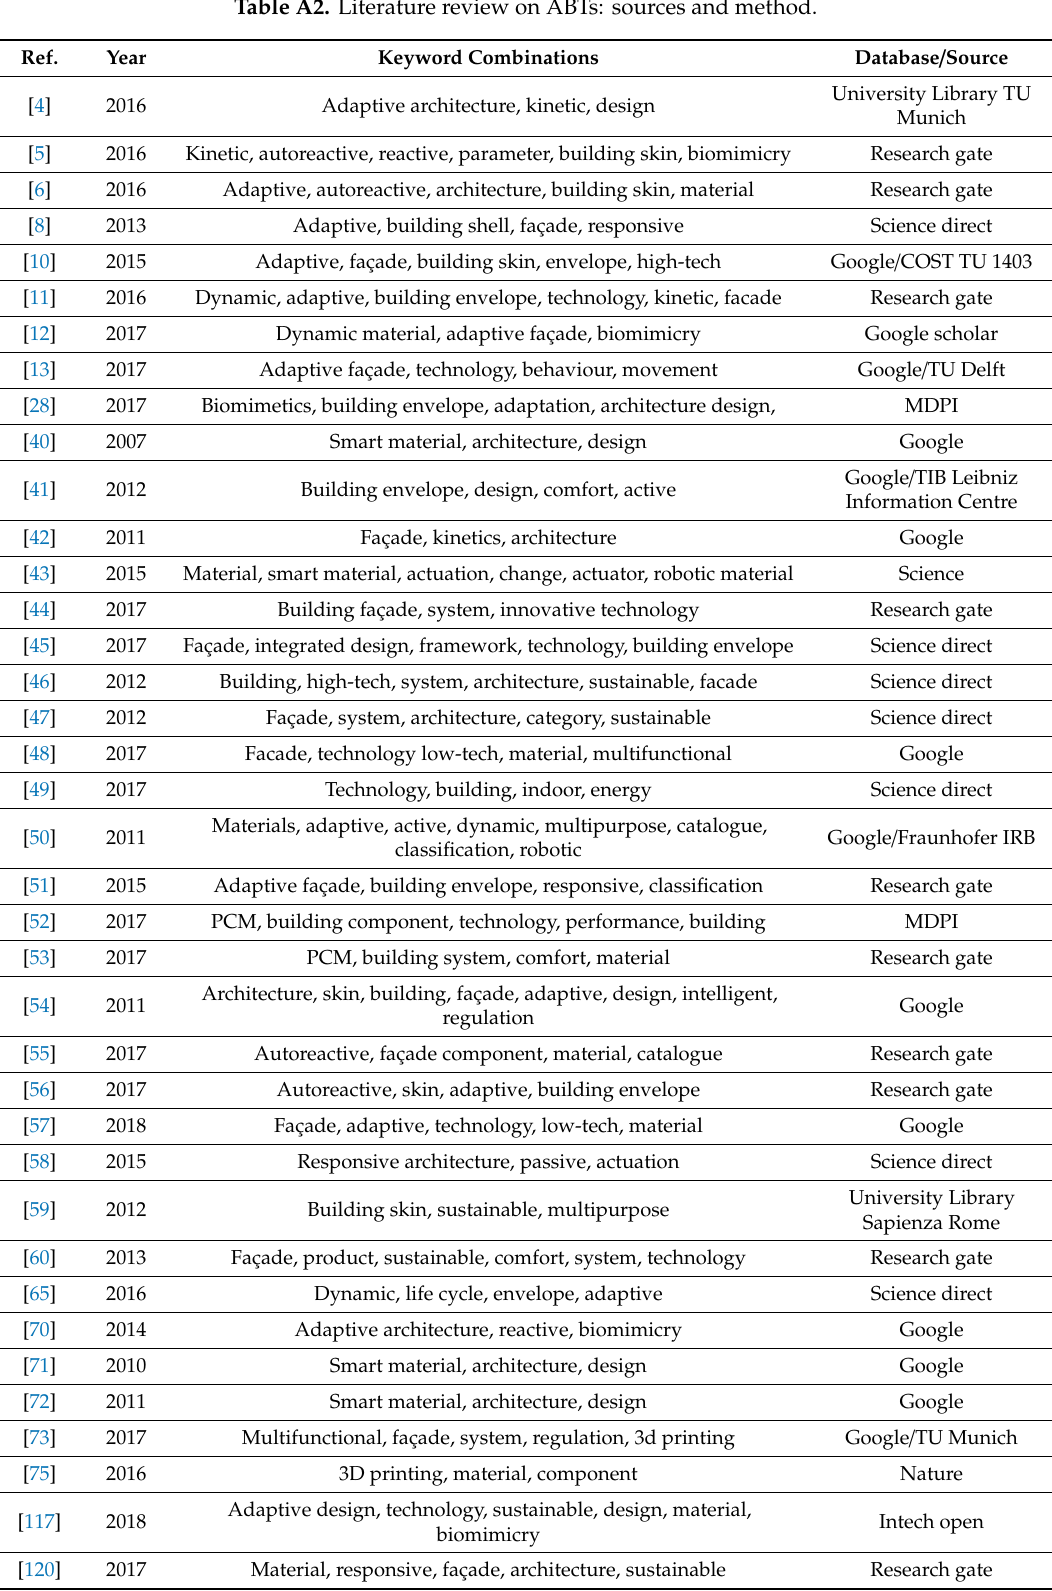
Table A2. Literature review on ABTs: sources and method.